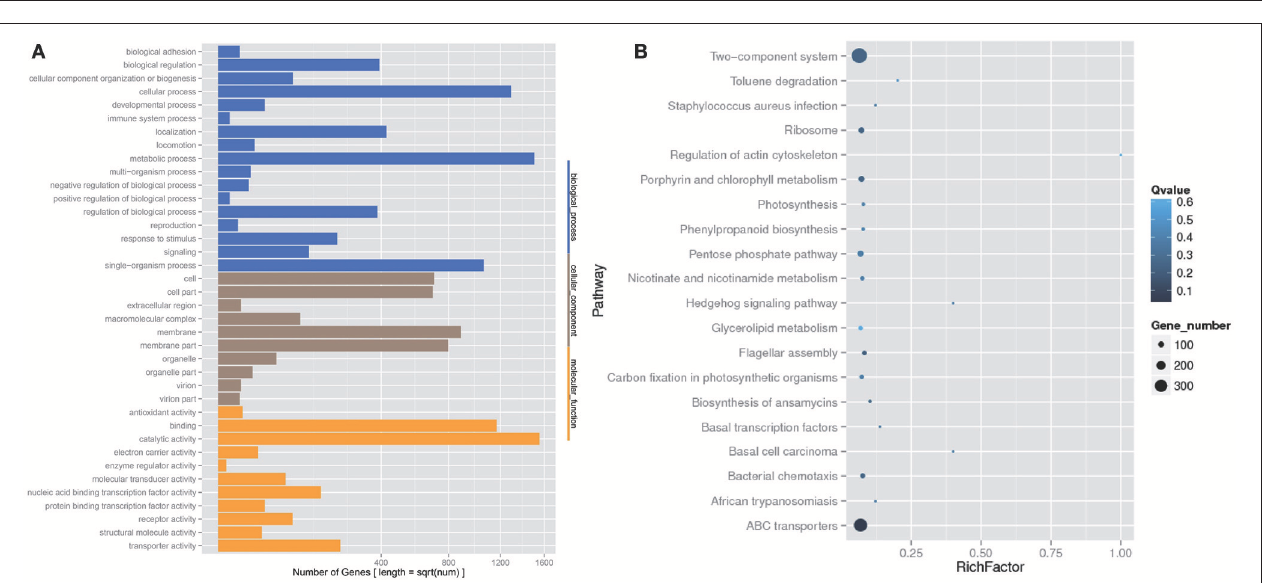
FIGURE 5 | Venn diagrams. The numbers of genes that were shared or not shared by the four individuals, depending on overlaps, are shown. For this presentation, two individuals had to be combined, thus affecting the number of genes shared by both individuals. (A) The number of genes shared by groups A and B. (B) The number of genes shared by the two individuals of group A. (C) The number of genes shared by the two individuals of group B.